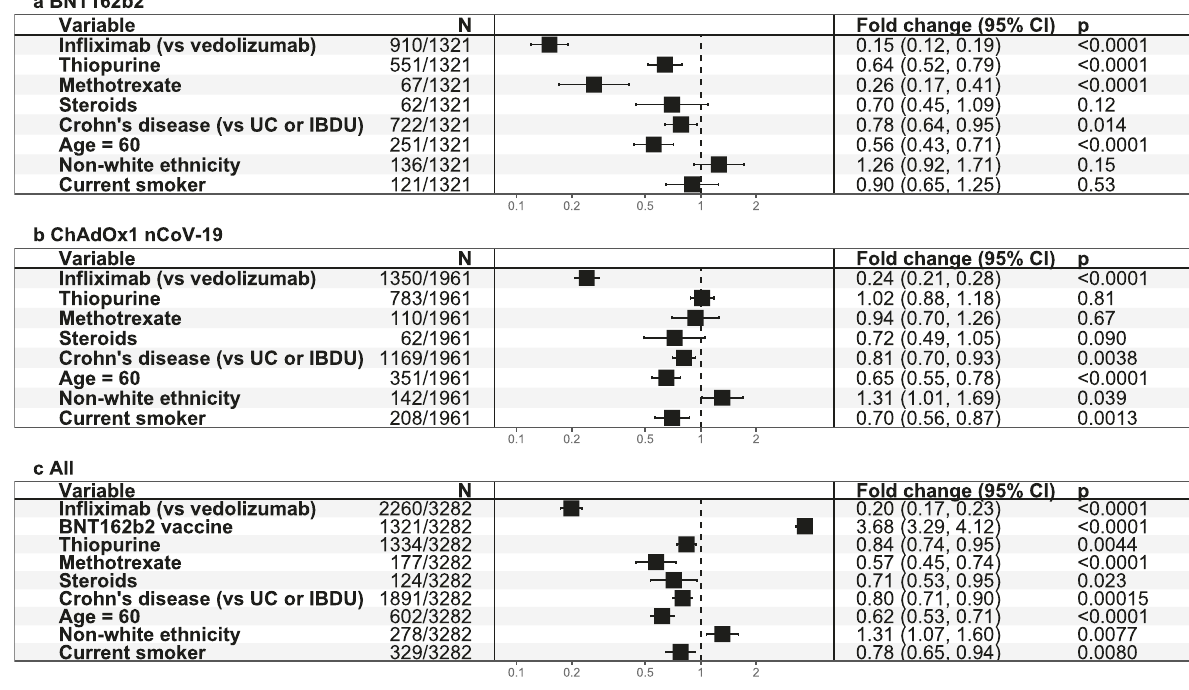
Fig. 2 Exponentiated coef fi cients of linear regression models of log anti-S RBD antibody concentration. Exponentiated coef fi cients of the linear regression model of log anti-S RBD antibody concentration in participants who received a BNT162b2 vaccine. b ChAdOx1 nCoV-19 vaccine. c either the BNT162b2 or ChAdOx1 nCoV-19 vaccine. The resultant values represent the fold change of antibody concentration associated with each variable (black square). The horizontal solid line through each square represents the 95% con fi dence interval. Each vaccine was modelled separately, and then a further model was created using all available data. The vertical dotted line represents a fold change of 1. Tests were two-tailed. p values were derived from linear regression using the t -test statistic and reported without correction for multiple testing. Source data are provided as a Source Data fi le. UC ulcerative colitis, IBDU IBD unclassi fi